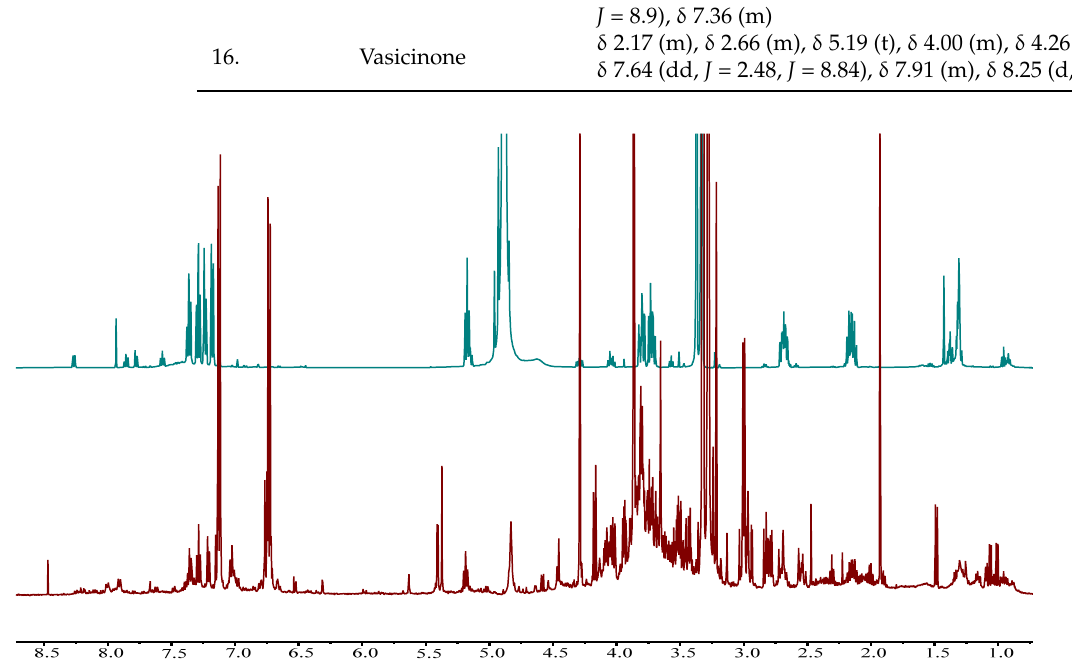
Figure 1. 1 H ‐ NMR spectrum (500 MHz) of alkaloid fraction (blue color) superimposed on 1 H ‐ NMR spectrum of mixture extract (brown color) from the sample collected at Khanpur (location 4 as per Table 1) both in 50% CD 3 OD–D 2 O.